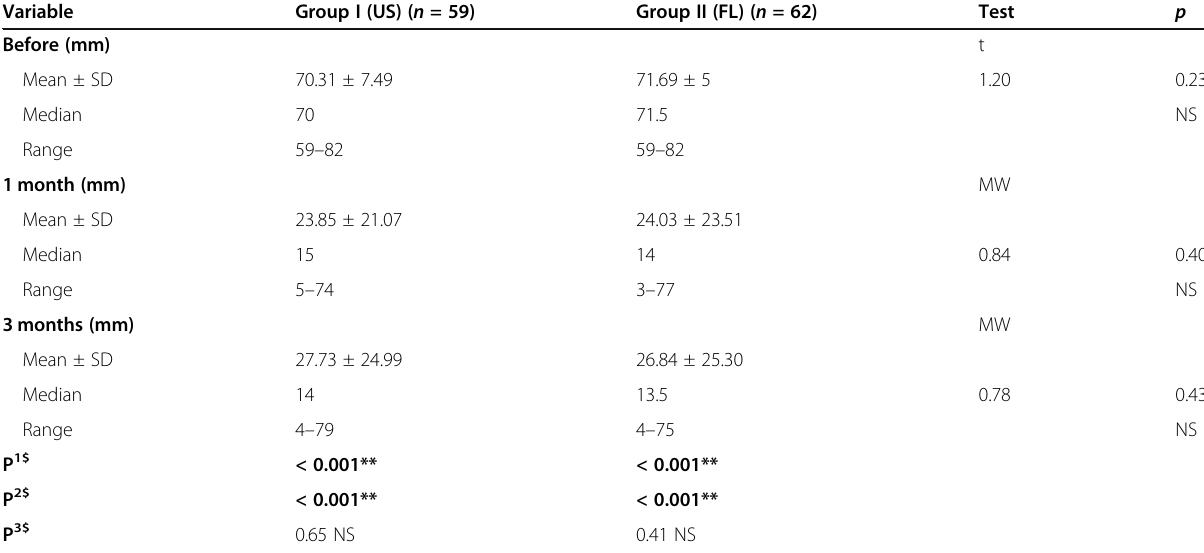
Table 3 Visual analogue scale of the two studied groups